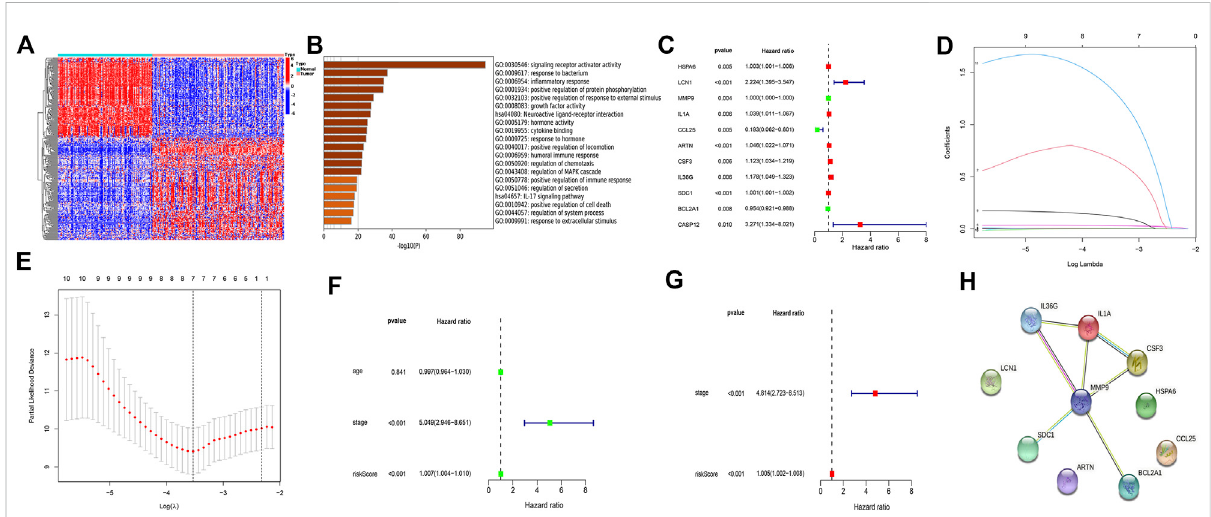
FIGURE 1 Identifying differential genes and building models. (A) Differential genes from TNBC and normal samples. (B) Pathway analysis of differential gene enrichment. (C) Eleven prognostic-related genes ( p < 0.05) based on the univariate regression analysis. (D,E) Least absolute shrinkage